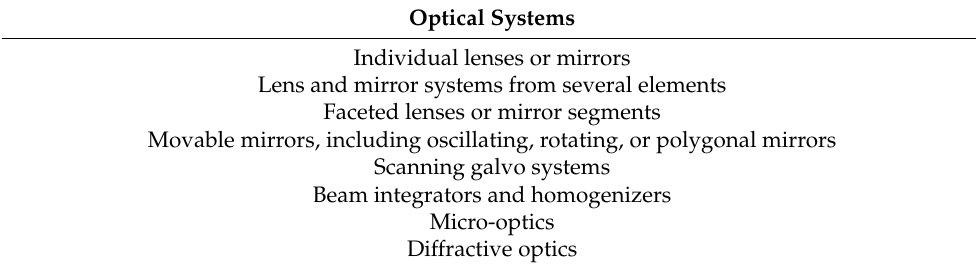
Table 1. Optical systems that are used for the shaping of laser beams with an intensity redistribution, Data from